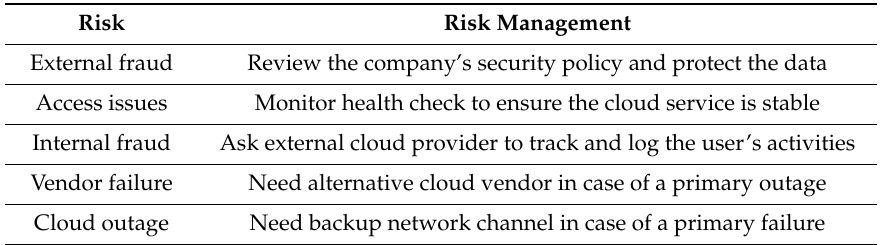
Table 2. The risks associated with the public cloud.